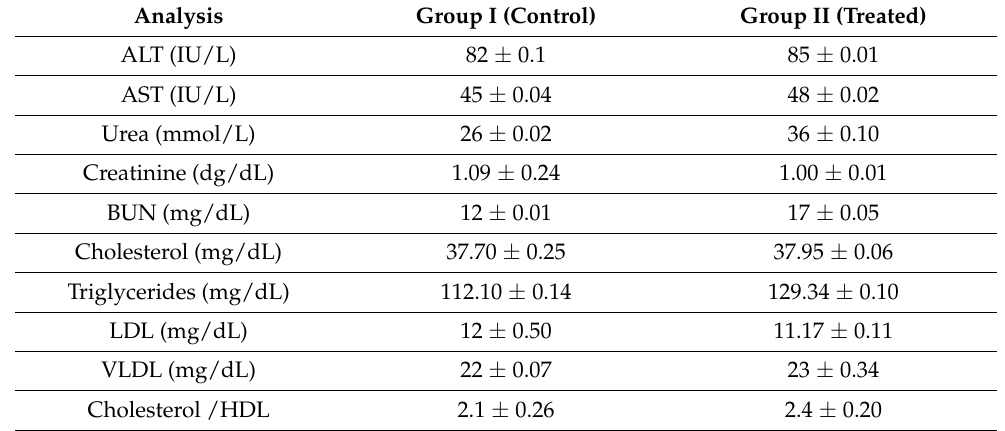
Table 6. Biochemical analysis.